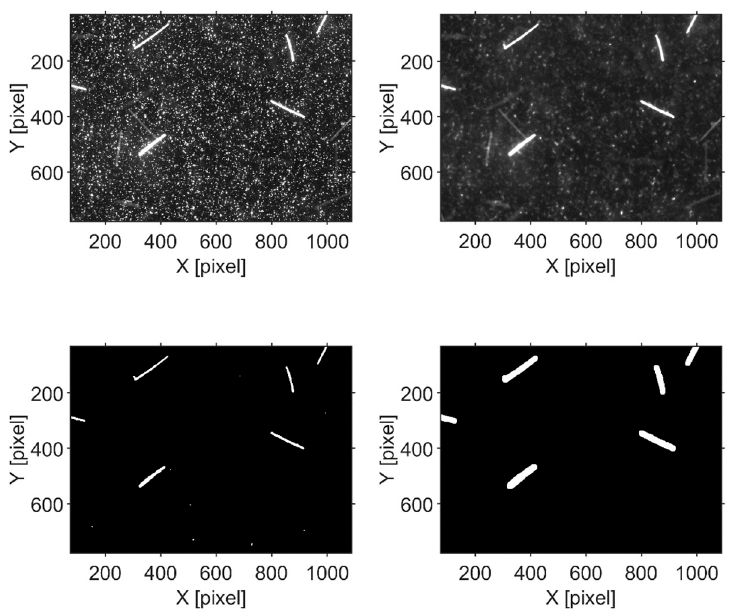
Figure 2. Processing and separation steps. Original raw image ( top left ). Image obtained after background subtraction and median filter application ( top right ). Binarized image ( bottom left ). Final mask image obtained by erosion and dilation operations ( bottom right ).